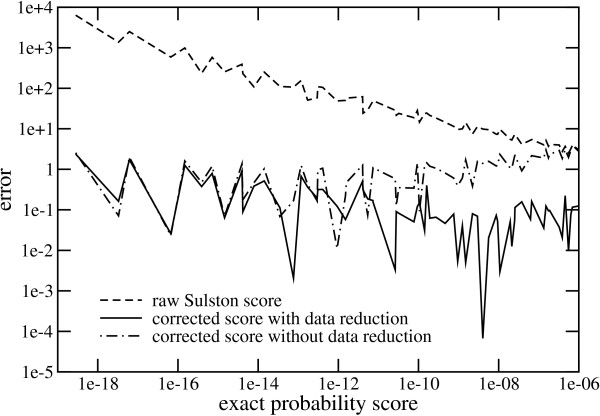
Error characterization for clones with similar numbers of fingerprint bands.